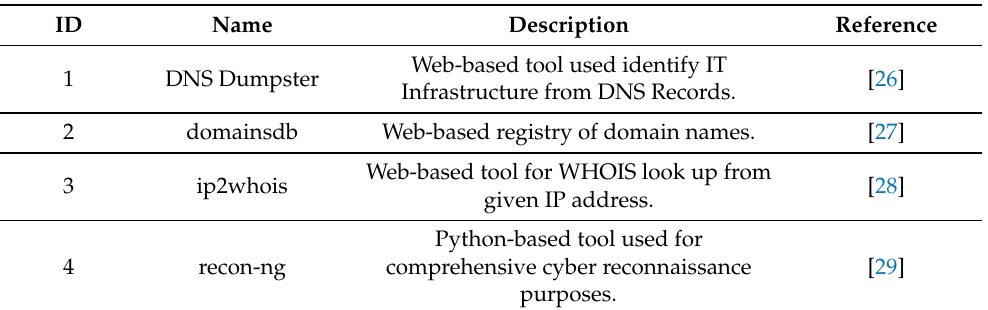
Table 2. Different tools used to obtain the OSINT information affiliated with the IT infrastructure of an